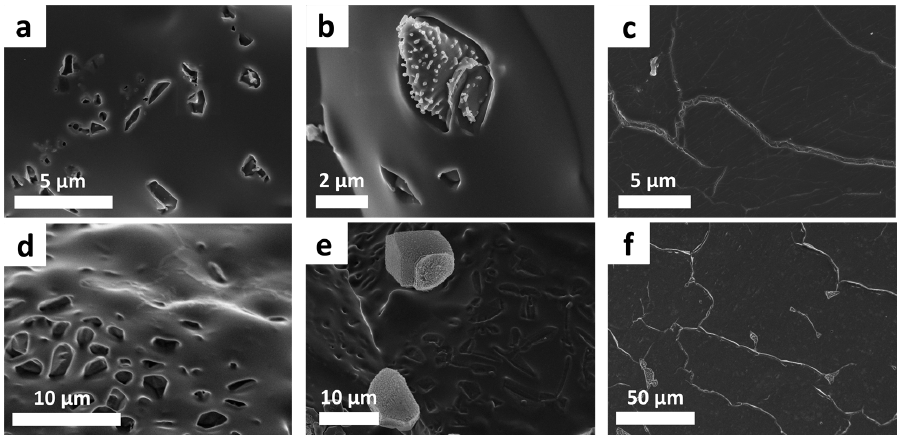
Figure 3. SEM-image of pS-DVB with 30 wt % DVB: ( a ) section with sulfur crystals and agglomerates; ( b ) sulfur crystals with spherical dots; ( c ) spherical dots on sulfur crystals and copolymer surface.